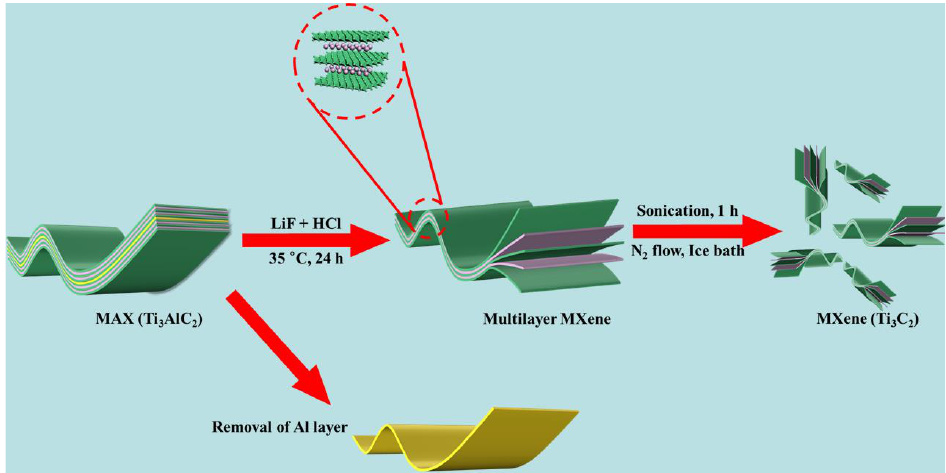
Figure 8. Schematic diagram of the synthesis procedure of ultrathin 2D MXene nanosheets.